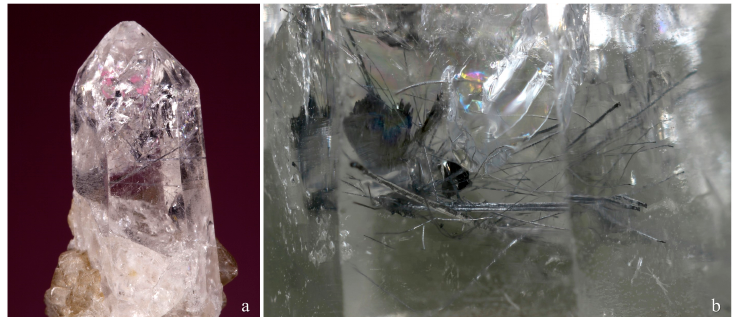
Figure 2. Optical photographs of ( a ) 2.8-cm-tall quartz crystal with inclusions of merelaniite whiskers, also associated with chabazite crystals; ( b ) close-up of (a) showing merelaniite, graphite and an unidentified fan-shaped phase at the left of the image (~8 mm wide field-of-view). (A. E. Seaman Mineral Museum collection DM 31315; ex. Simon Harrison collection.).